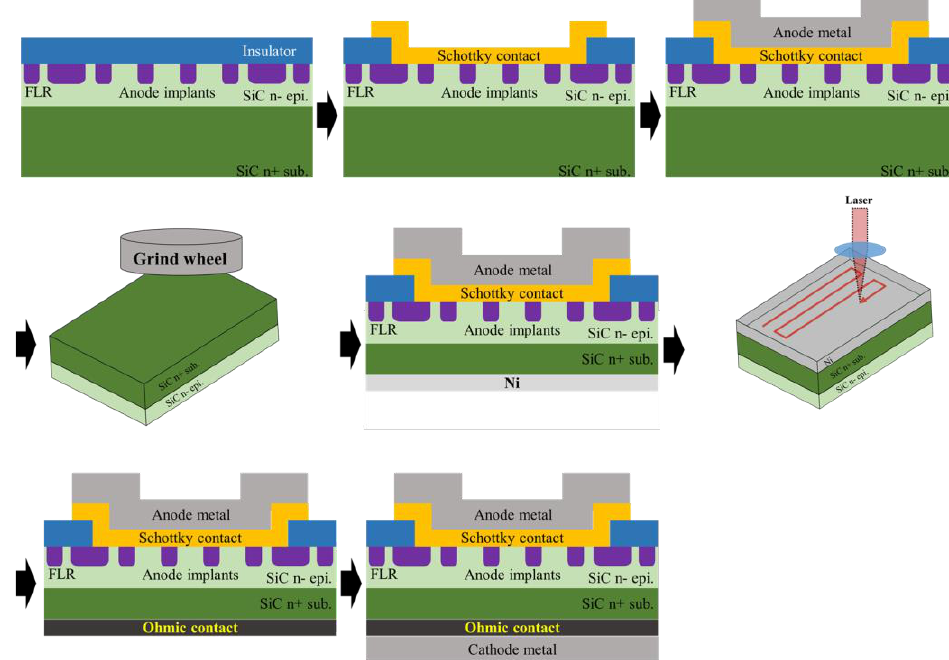
Figure 1. Schematic flow chart of the fabrication of a JBS diode with grinding and laser annealing processes.